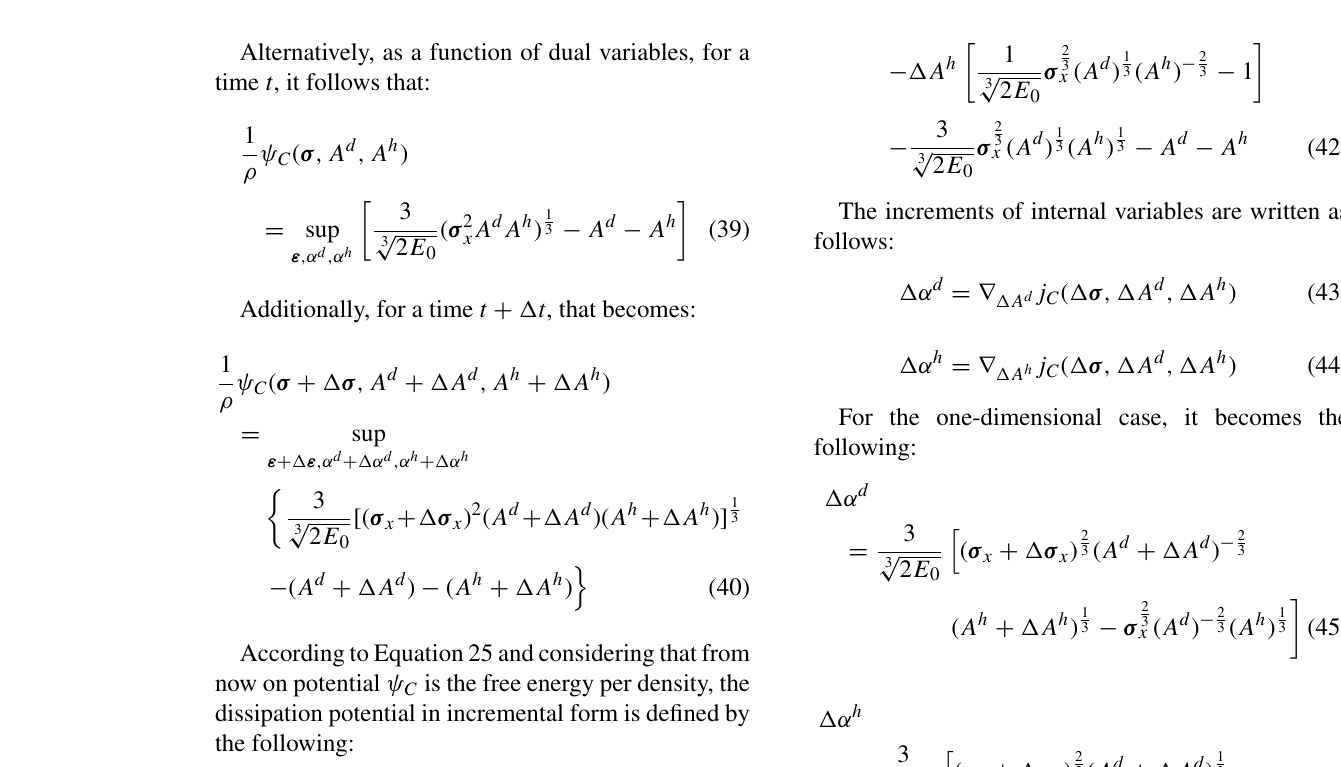
F.V. Tormena et al. / A bone remodelling model based on generalised thermodynamic